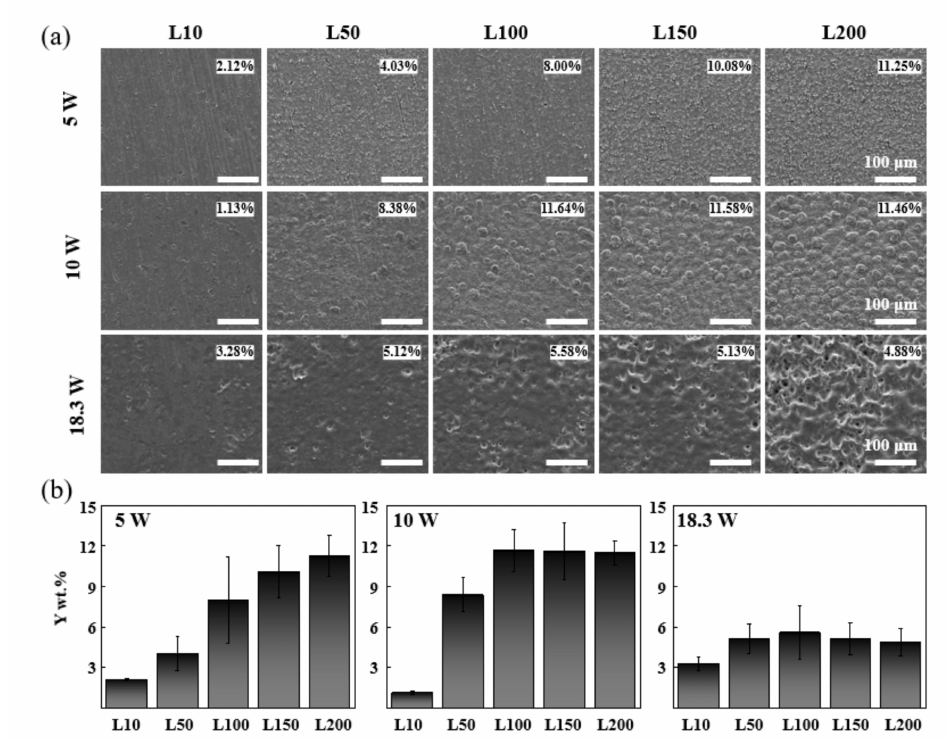
Figure 3. ( a ) SEM images of the laser-treated Al substrate showing surface morphology, and ( b ) weight percentage of coated Y on the Al substrate depending on laser parameters (power, loop) in a mixture of Y(NO 3 ) 3 and NaF precursor solution. In the SEM images, the numerical values indicate the weight percentage of